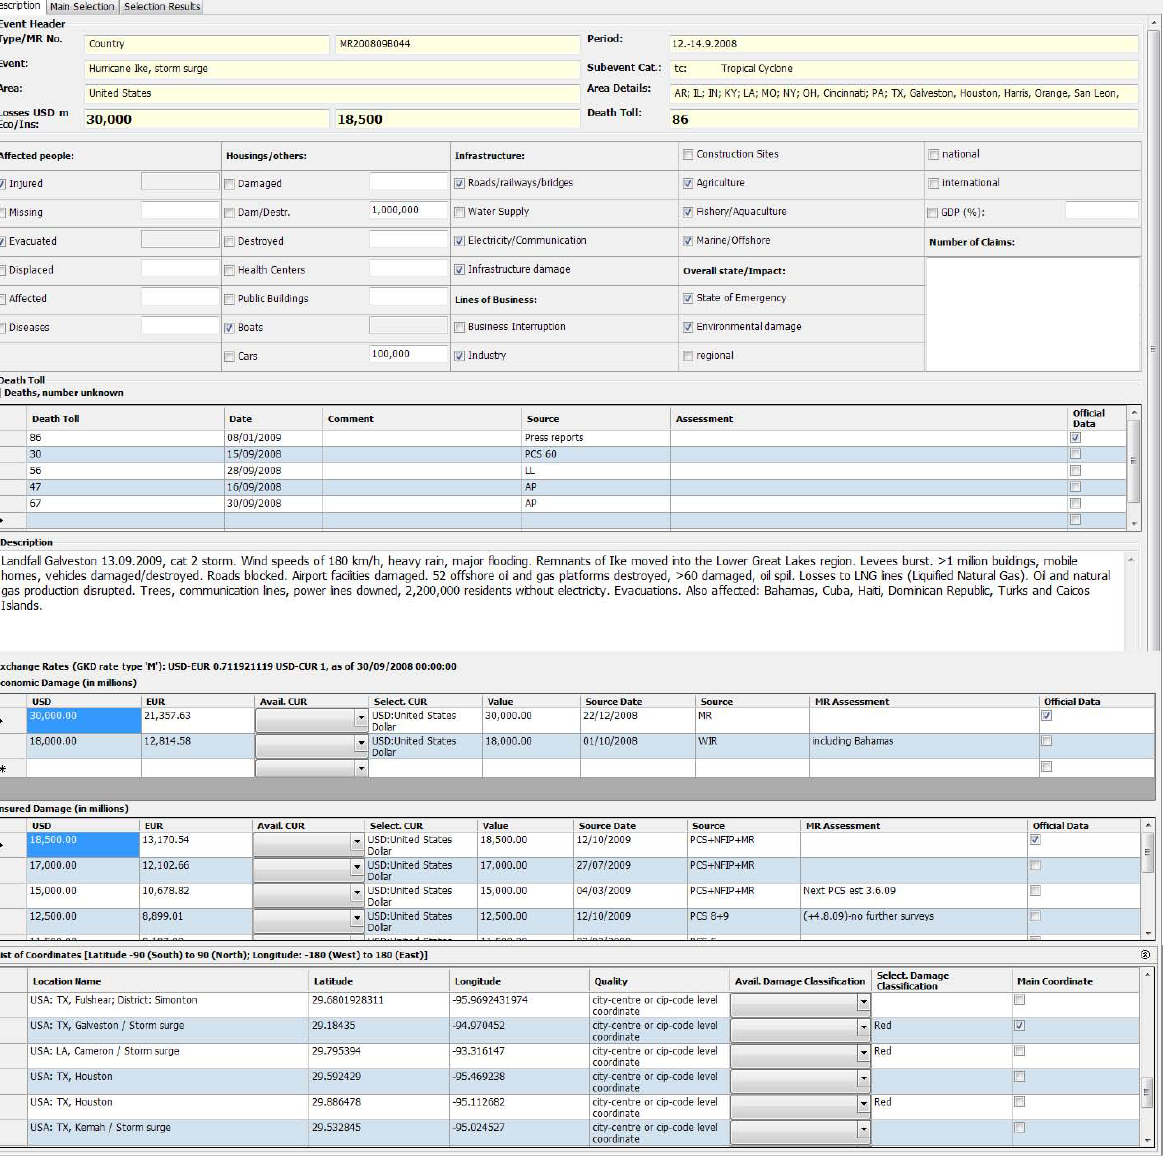
Fig. 2. Sample NatCatSERVICE entry (Hurricane Ike